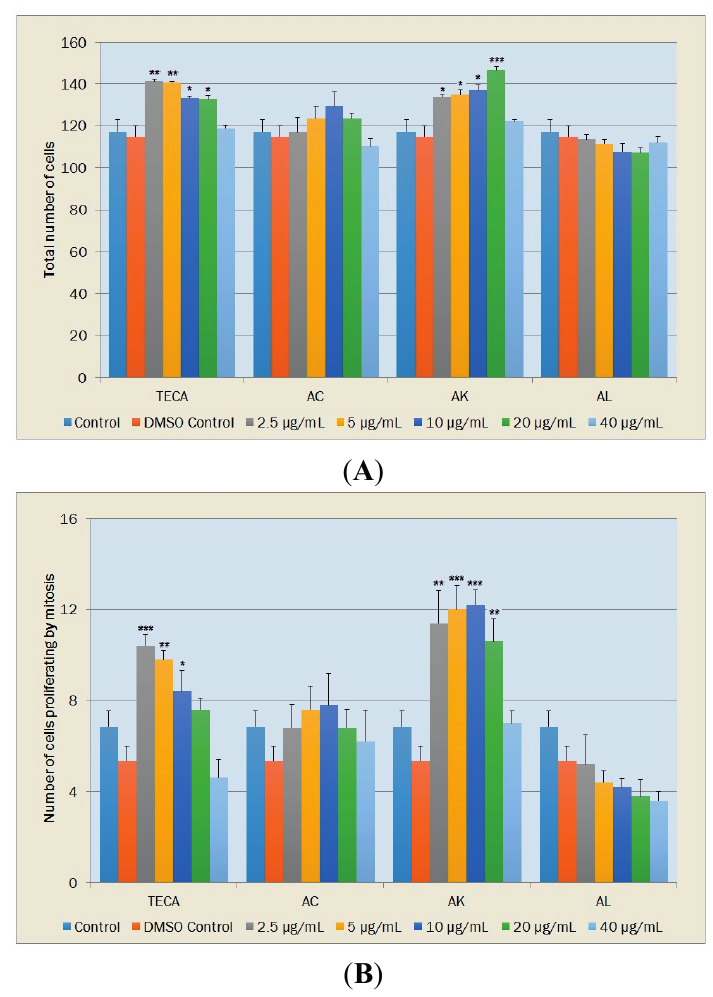
Figure 5. Effects of TECA, AC, AK and AL extracts on cell proliferation. ( A ) Total number of NIH-3T3 fibroblasts; ( B ) Total number of fibroblasts proliferating by mitosis Data are mean ± SEM values (cells/mm 2 , n = 5 in each case). * p < 0.05, ** p < 0.01, *** p < 0.001, significantly different from control